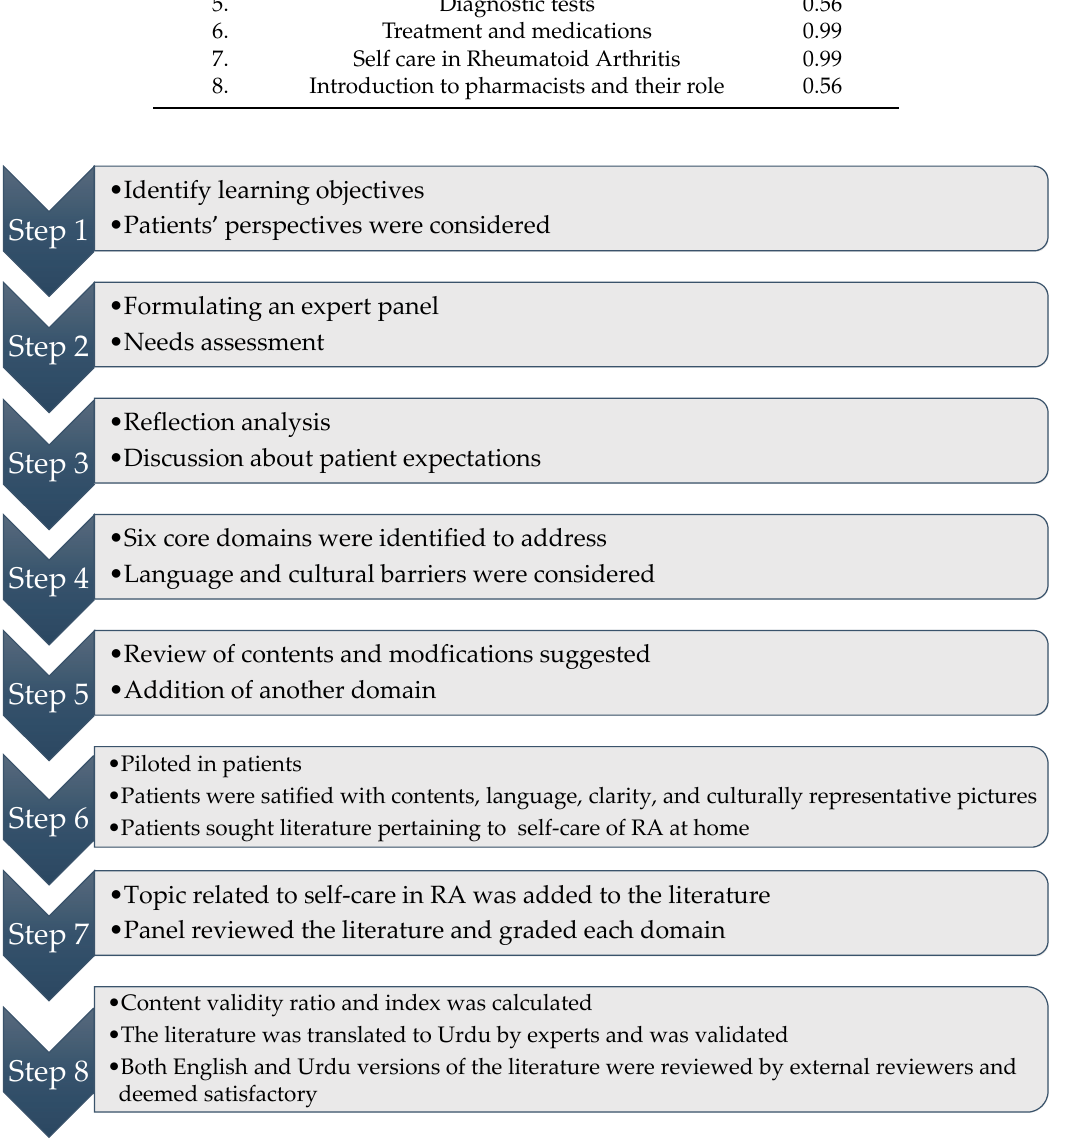
Figure 1. Flowchart of the development process of literature.